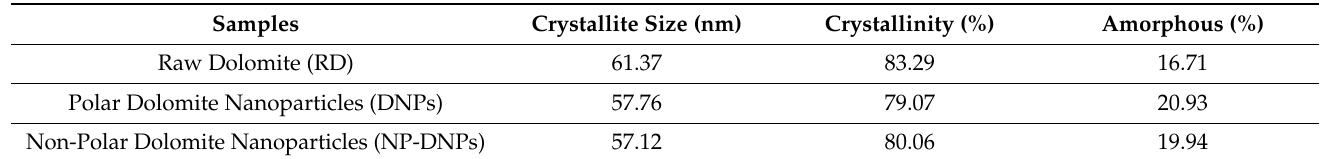
Table 1. The crystallite size and crystallinity of raw dolomite (RD), dolomite nanoparticles (DNPs), and non-polar dolomite nanoparticles (NP-DNPs).